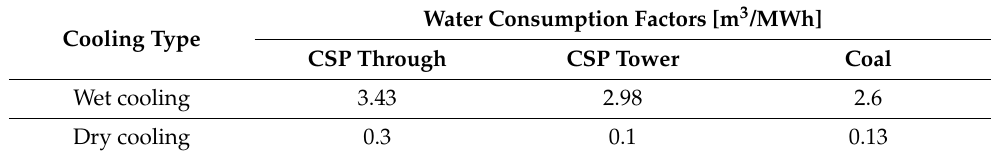
Table 8. Water consumption factors for CSP with various cooling technologies